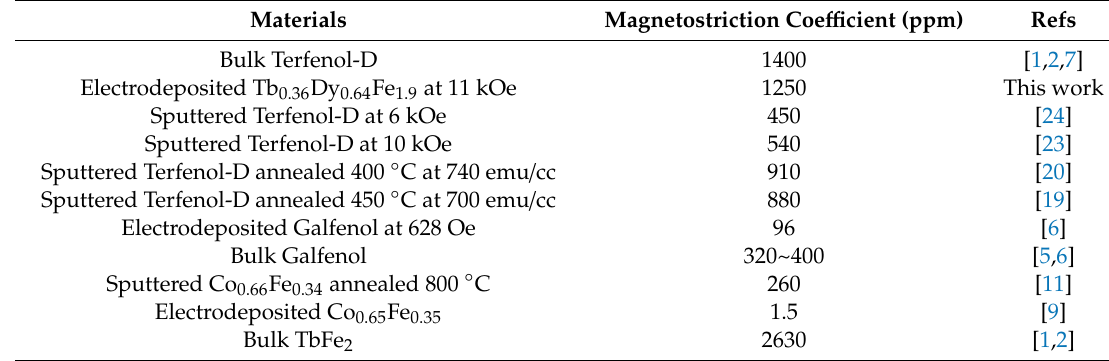
Table3. Comparisonofthemagnetostrictivecoefficientsamongbulkvalues,sputtered,andelectrochemical deposited Table 3. Comparison of the magnetostrictive coefficients among bulk values, sputtered, and electrochemical deposited films.